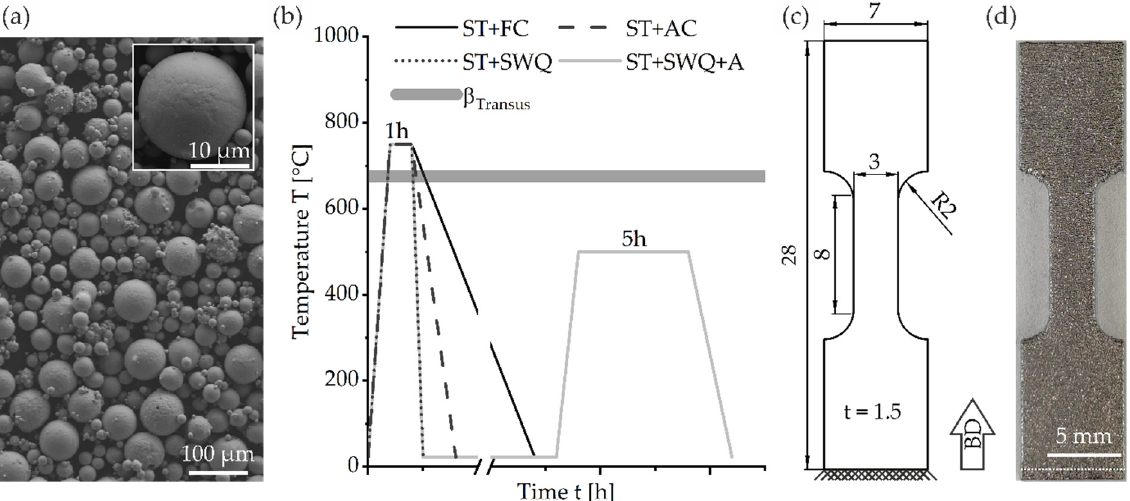
Figure 1. ( a ) SEM image of the morphology of initial Ti2448 powder, inset showing a spherical powder particle in higher magnification; ( b ) schematic overview of the heat treatments (ST = solution treatment, FC = furnace cooling, AC = air cooling, SWQ = slow water quenching in a glass ampule, A = aging) as well as the β Transus temperature; ( c ) geometry in reference to the building direction (BD) of the tensile specimens; ( d ) image of an as-built sample, support structure below the white dashed line.